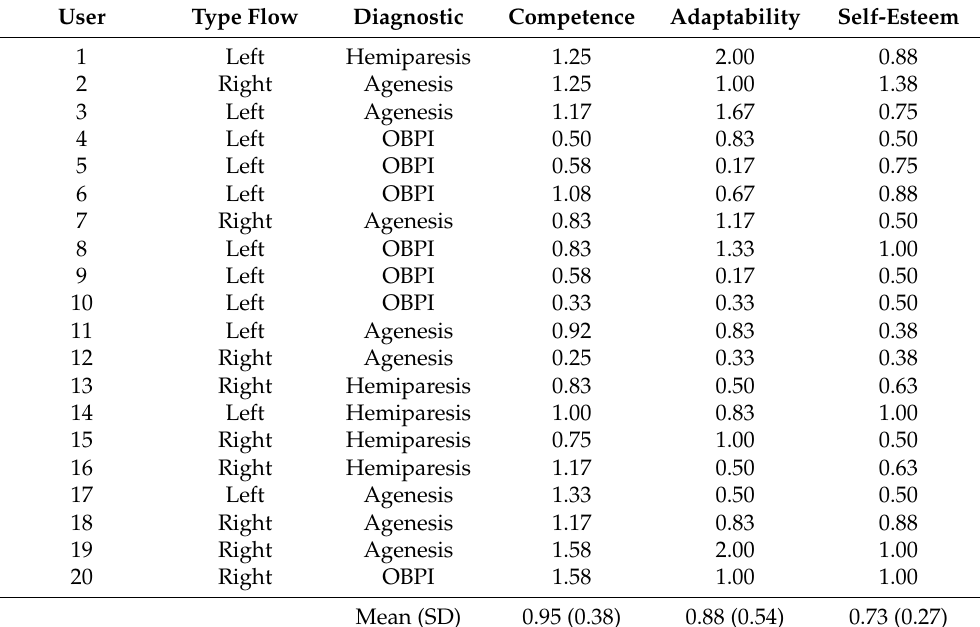
Table 5. Results from participants’